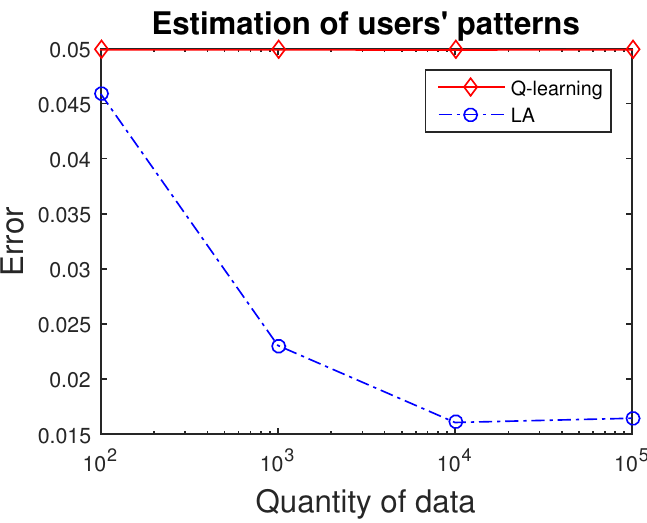
Figure 5. Applying reinforcement learning methods to estimate users’ patterns. The learning automata (LA) method is superior to the Q-learning method, and converges when the quantity of data increases to 10 4